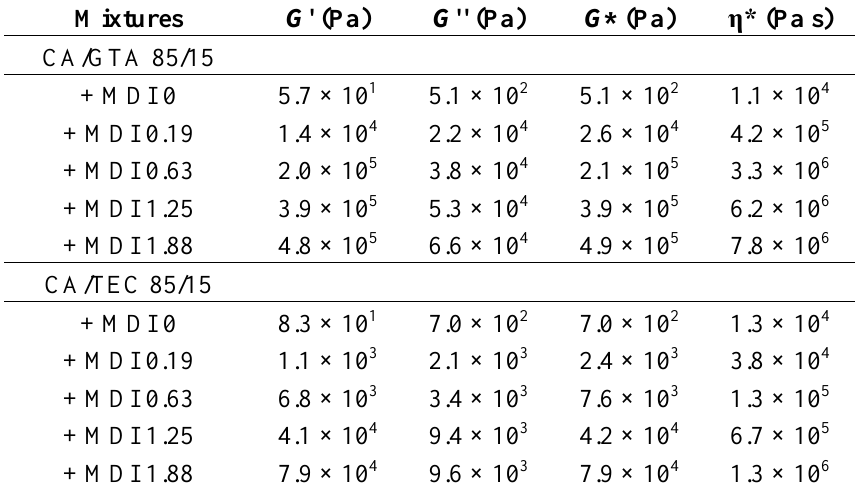
Table 4. Viscoelastic properties for CA/GTA/MDI and CA/TEC/MDI at 0.01 Hz and 220